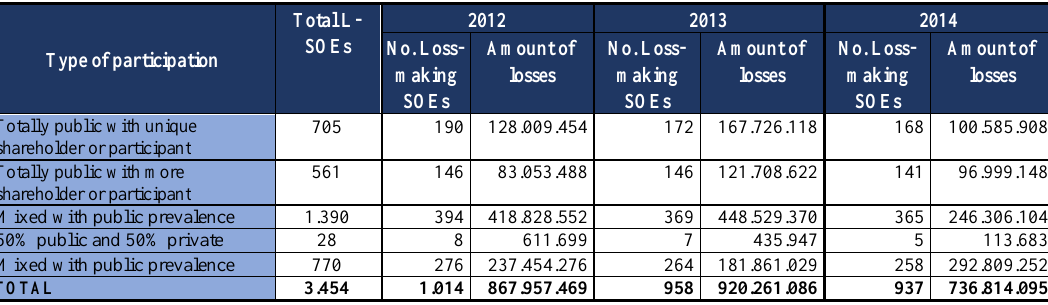
Table 3: Number and amount of losses of L-SOEs Type of participation 50% public and 50% private 28 611.699 7 435.947 5 113.683 Mixed with public prevalence 770